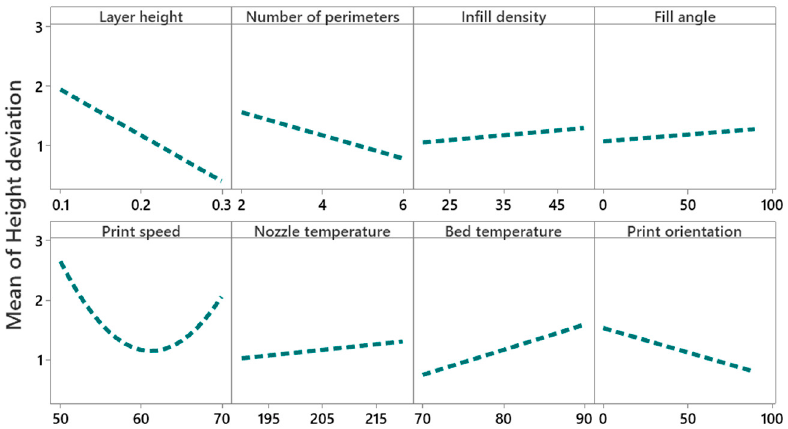
Figure 11. Main effect plot for height deviation.